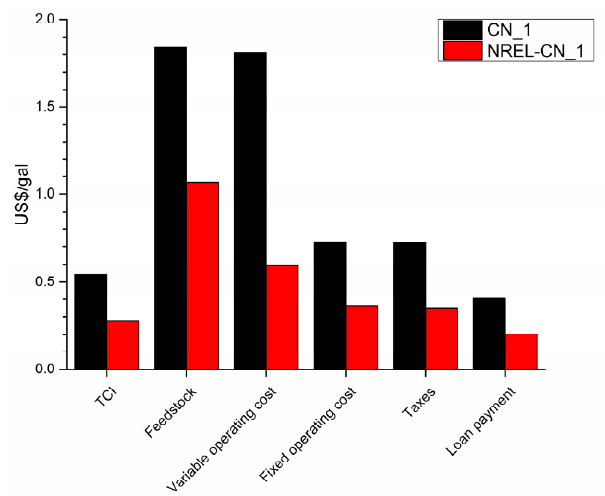
Figure 9. Costs of different